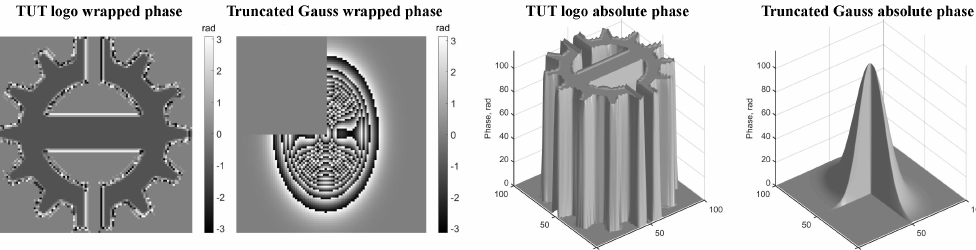
Figure 2. Wrapped and absolute phases of the investigated test-objects: truncated Gaussian and TUT logo, the reference wavelength λ (cid:48) = λ 3